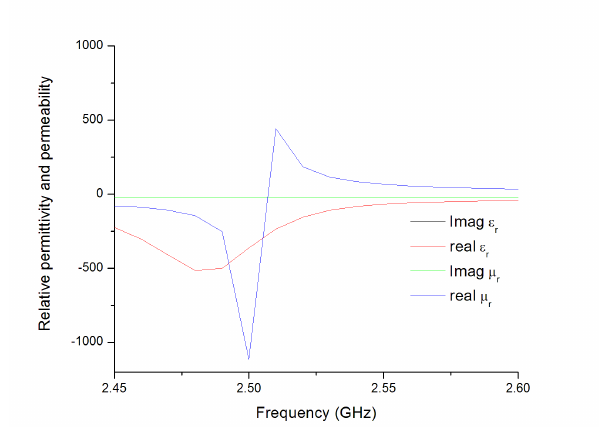
Figure 2: Relative permittivity and relative permeability vs. frequency for the antenna with CSRR